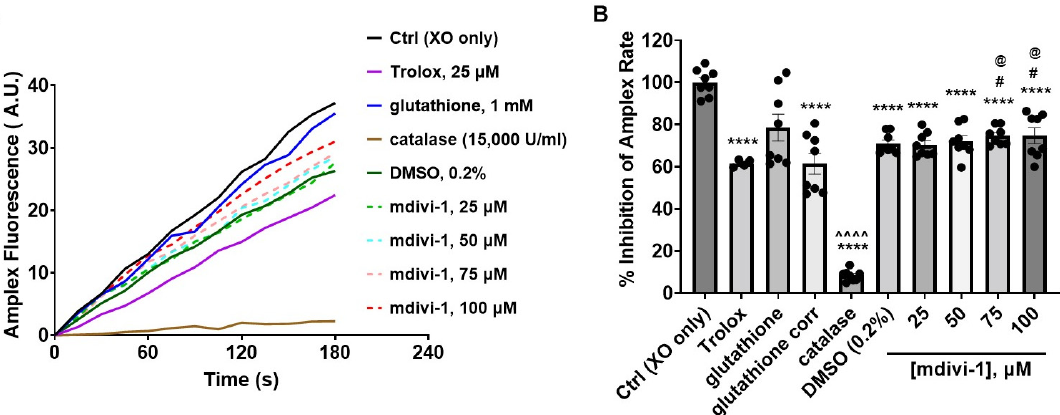
Figure 5. Effect of mdivi-1 on Amplex UltraRed oxidation rate. ( A ) Fluorescence in arbitrary units (A.U.) of Amplex UltraRed (Amplex) oxidation product monitored over time following xanthine oxidase (XO) addition in the absence (Ctrl, control) or presence of mdivi-1 (25–100 µ M), DMSO (0.2%, vehicle for mdivi-1), Trolox (25 µ M), glutathione (1 mM) or catalase (15,000 U/mL). Glutathione was prepared from powder in the aqueous Amplex assay medium and Trolox was diluted from a 50 mM stock prepared in water. Traces are means of quadruplicate wells and are representative of the experiment run on two different days. Trolox was only included on one of the days (depicted). ( B ) Amplex UltraRed oxidation rates expressed as a percentage of the Ctrl rate. Data are mean ± SEM, n = 4 for Trolox, and n = 8 for all others. An uncorrected representative glutathione trace is shown in ( A ), and both the uncorrected and corrected (corr, i.e., background-subtracted) rates are given in ( B ). Only the corrected rates were used for statistical analysis. A two-way mixed-model ANOVA followed by Bonferroni’s multiple comparisons post hoc test was used to test for differences among treatments, with treatment and experiment day as factors. Both treatment (F-value (8, 58) = 97.25, p < 0.0001) and the experiment day (F-value (1, 58) = 10.50, p = 0.002) had a significant effect, accounting for 92.18% and 1.244% of the total variation, respectively. **** p < 0.0001 compared to Ctrl, # p < 0.05 compared to Trolox, @ p < 0.05 compared to glutathione corr, ˆˆˆˆ p < 0.0001 compared to all other